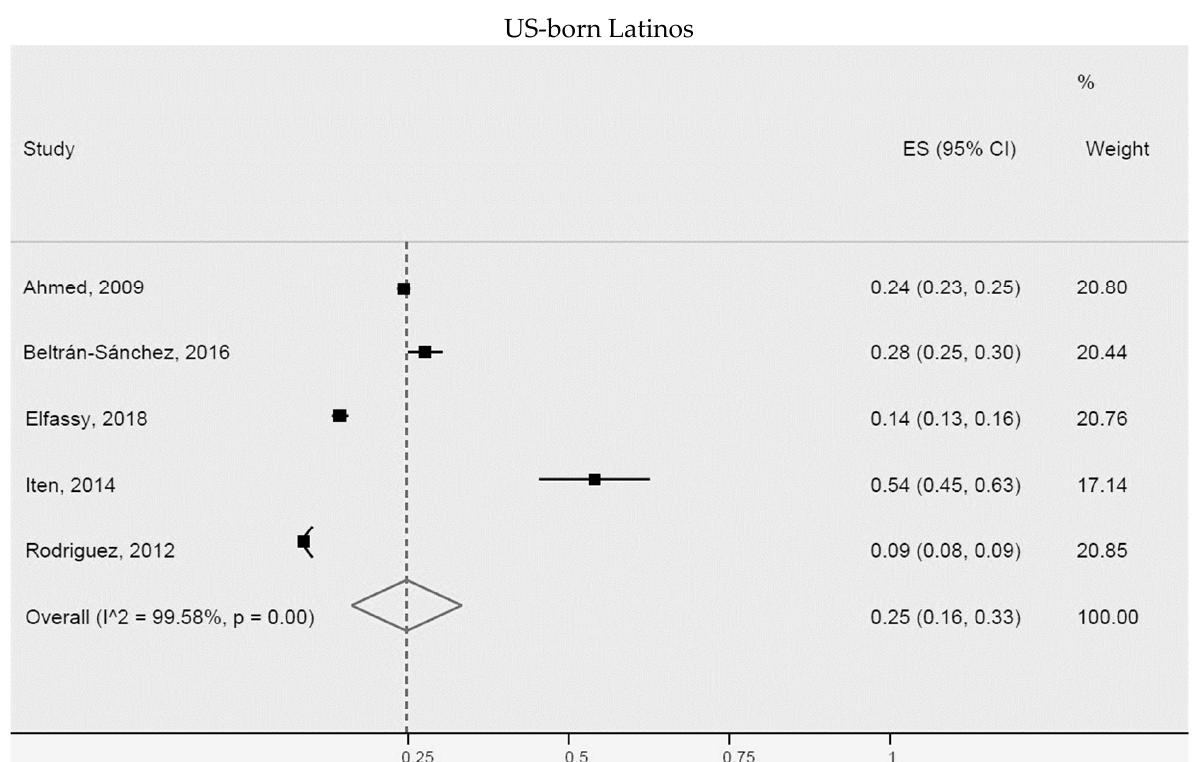
Figure 5. Type 2 diabetes mellitus or high blood glucose for immigrant Latinos and US-born Latinos. ES = Estimated proportion/prevalence; CI = Confidence interval; I^2 = I 2 index.